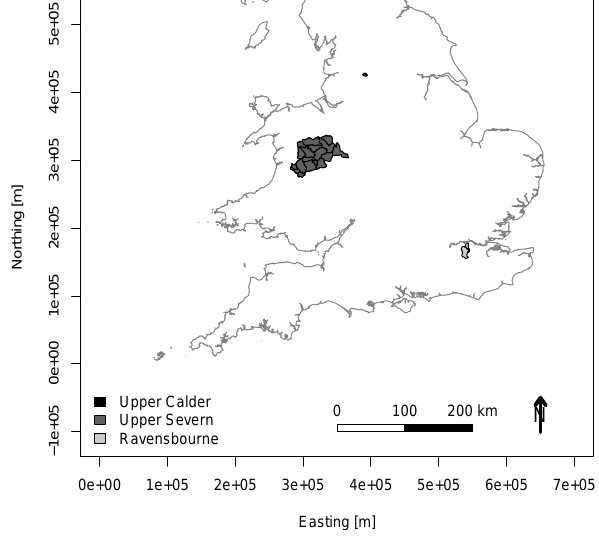
Fig. 1. Overview of the locations of the case study areas relative to the coastline of England and Wales. At the top the catchment of the Upper Calder, in the middle the Upper Severn with multiple interconnected catchments and at the bottom the two Ravensbourne